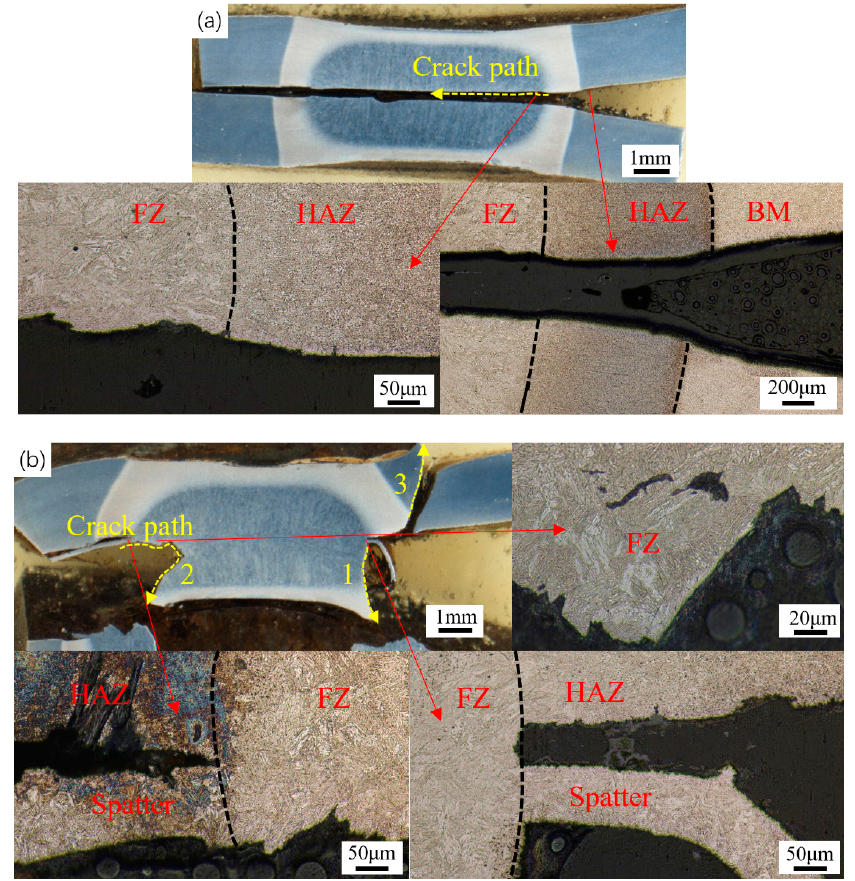
Figure 13. Weld cross-section with typical failure modes: ( a ) IF (10 kA, 20 cyc); ( b ) PIF (14 kA, 20 cyc).